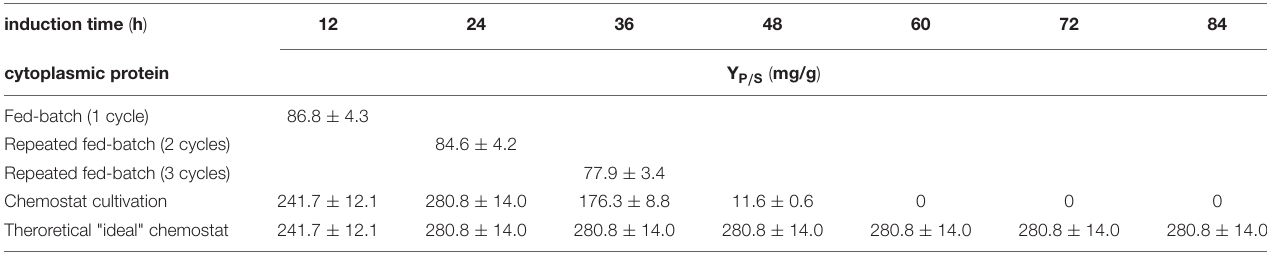
TABLE 4 | Comparing substrate per product yield for the production of a cytoplasmic protein; each cycle is investigated separately for fed-batch and repeated fed-batch cultivation; chemostat cultivation is calculated as a rate every 12 h (i.e., one cycle).